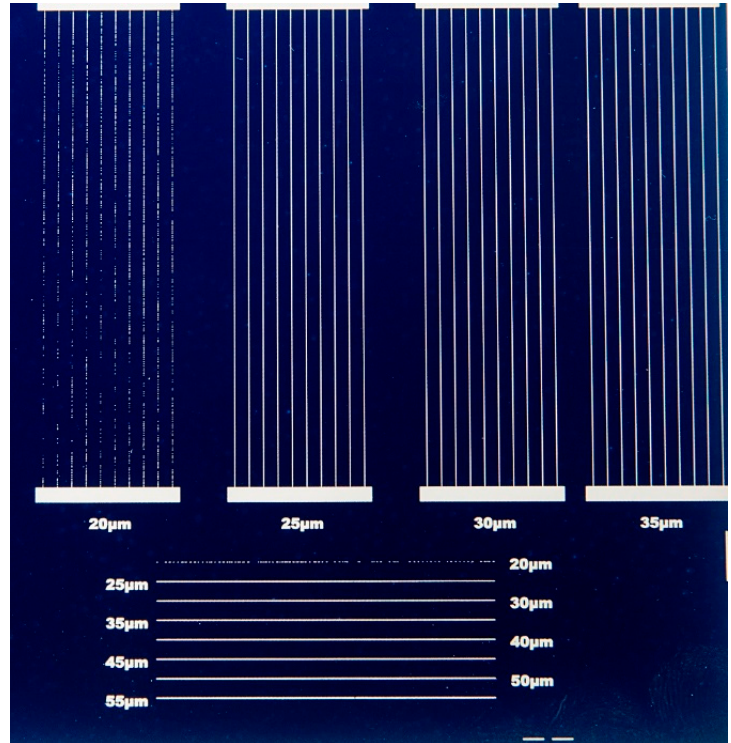
Figure 7. Model silver paste M3 printed on a (Cz) Si wafer using a test layout pattern with eight different finger openings between 20 and 55 µm at printing speed v print = 210 mm s − 1 .